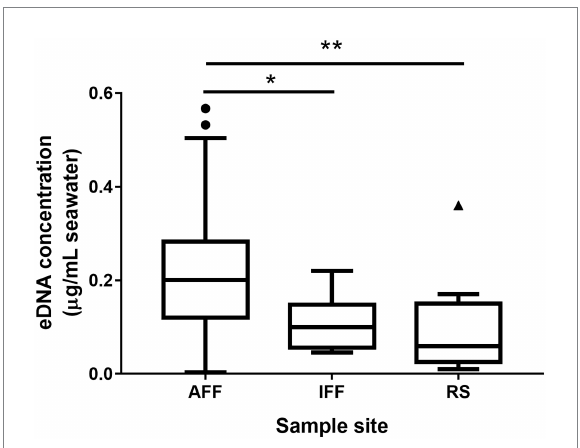
FIGURE 2 Environmental DNA concentrations in sampled Hong Kong fish farms and open waters. Asterisks indicate statistically significant difference (Kruskal-Wallis test, p < 0.05). AFF, active fish farms; IFF, inactive fish farms; RS, open water reference sites. Asterisks indicate statistically significant difference according to corresponding statistical tests mentioned in figure i.e., Mann Whitney U-test or Kruskal-Wallis test. * indicates p < 0.05 and ** indicates p <